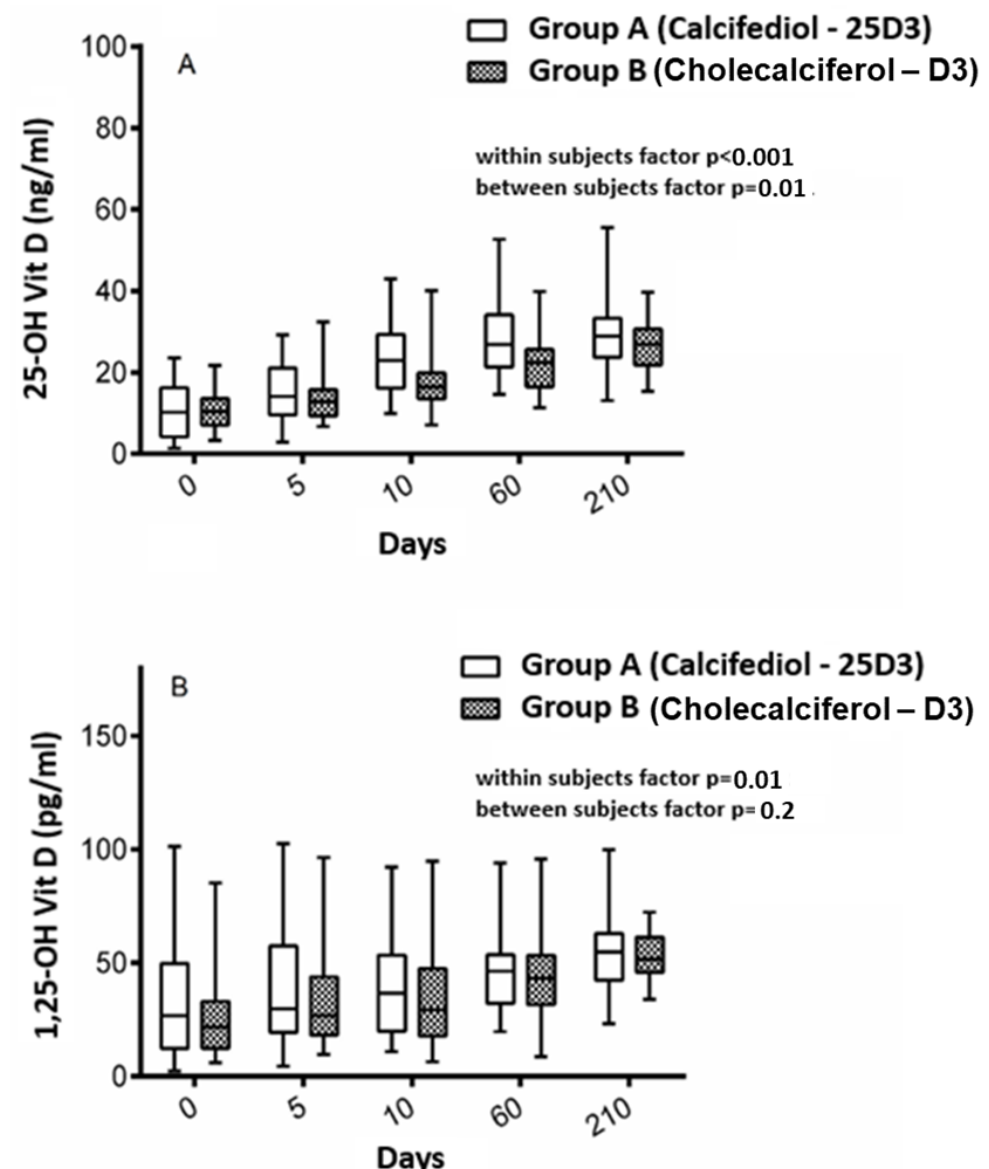
Figure 1. Serum levels of the metabolites of vitamin D over time among participants grouped according to the type of intervention. Panel A shows the serum levels of 25(OH)D over time among participants belonging to group A, those receiving calcifediol, and group B, those receiving cholecalciferol. Panel B shows the serum levels of 1-25(OH)D over time among participants belonging to group A, those receiving calcifediol, and group B, those receiving cholecalciferol.